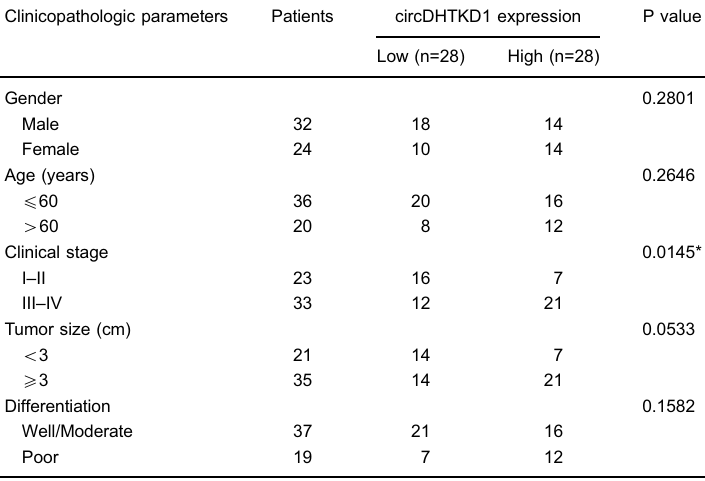
Table 1. Correlation between circDHTKD1 expression and clinicopathological characteristics in oral squamous cell carcinoma patients